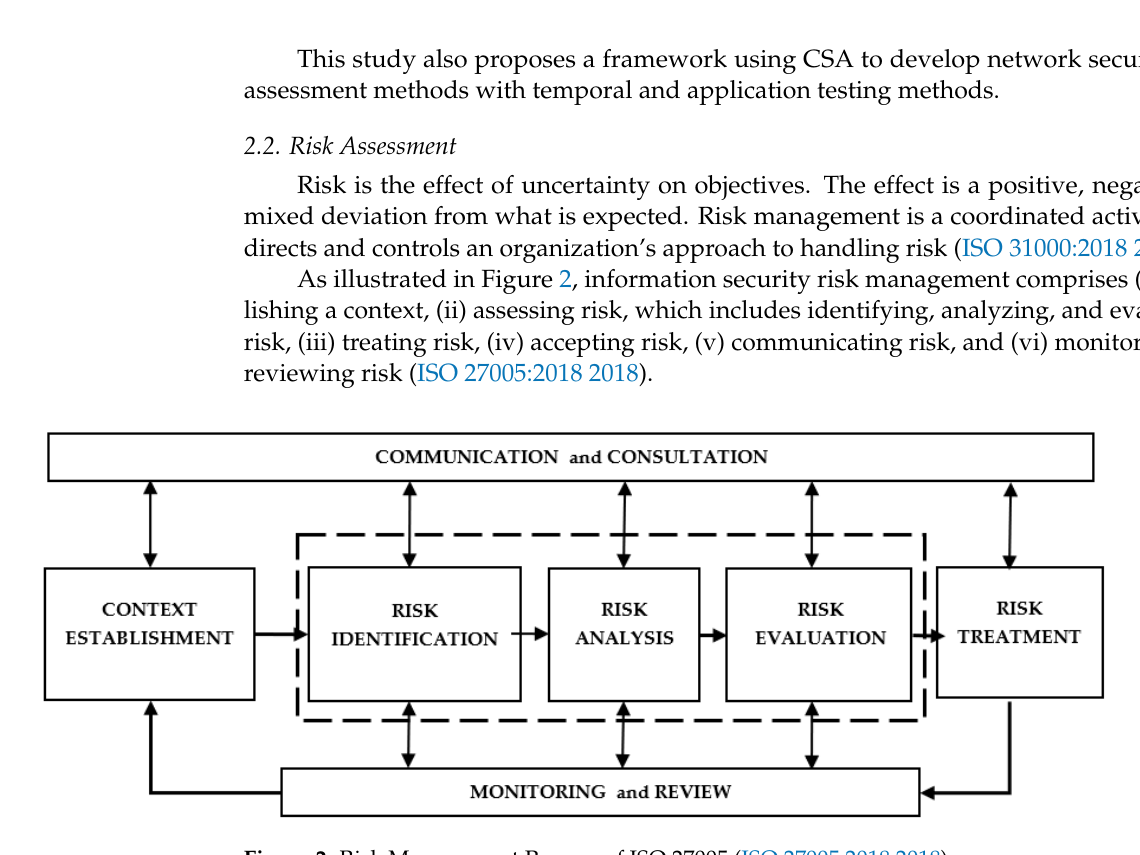
Figure 2. Risk Management Process of ISO 27005 (ISO 27005:2018 2018).